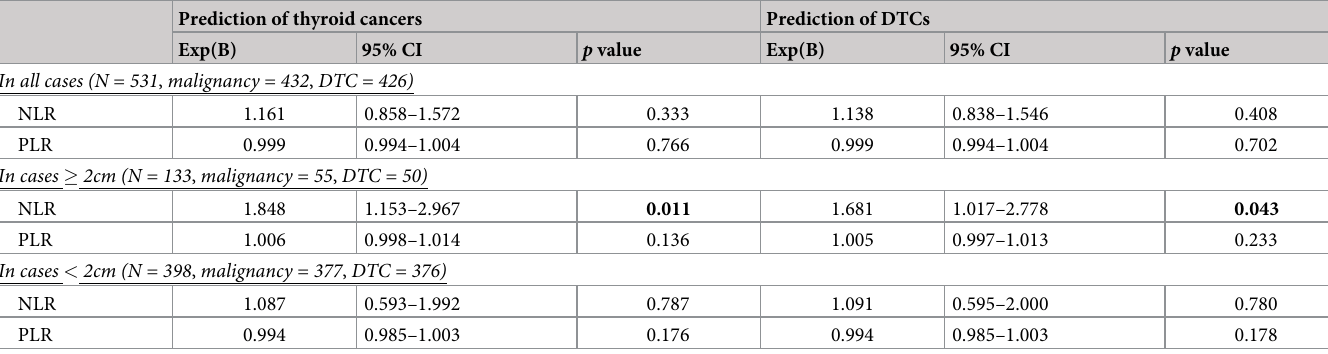
Table 3. Prediction of thyroid cancers with systemic inflammatory markers. Prediction of thyroid